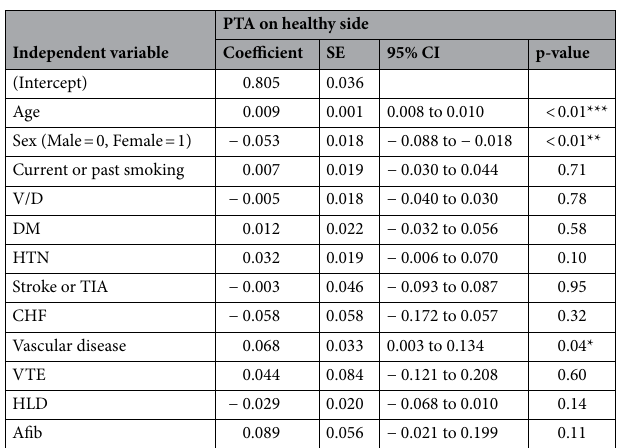
Table 4. Results of multivariate regression of atherosclerosis factors predicting severity of hearing loss (PTA) on healthy side. Same abbreviations as in Table 1. Dependent variable = PTA on healthy side. Multiple R 2